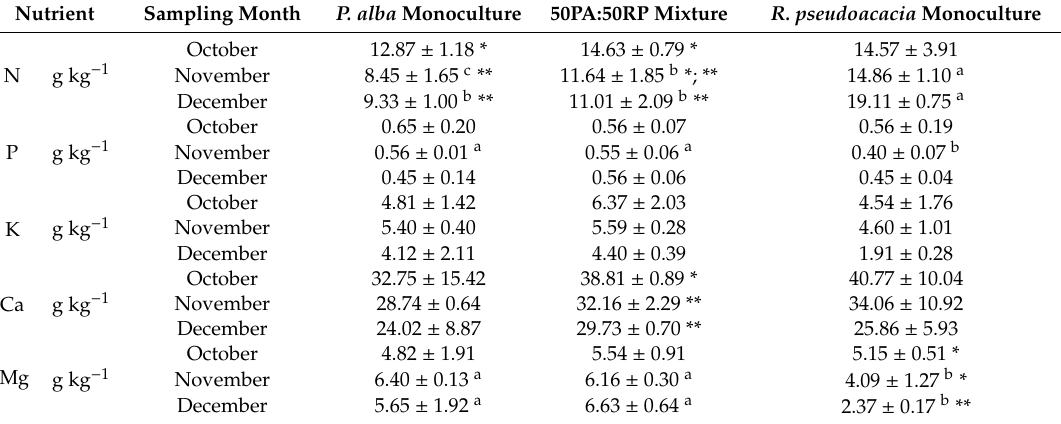
Table 3. Monthly averages ± standard deviation of NPK concentrations in senescent leaves collected in October, November and December in P. alba and R. pseudoacacia monoculture plots and mixed (50PA:50RP) plots.